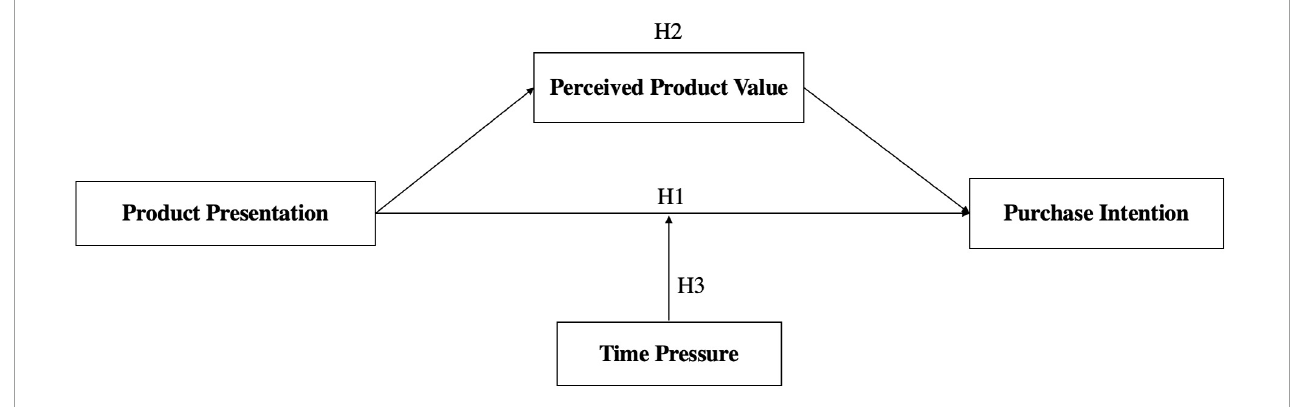
FIGURE1 The research framework.